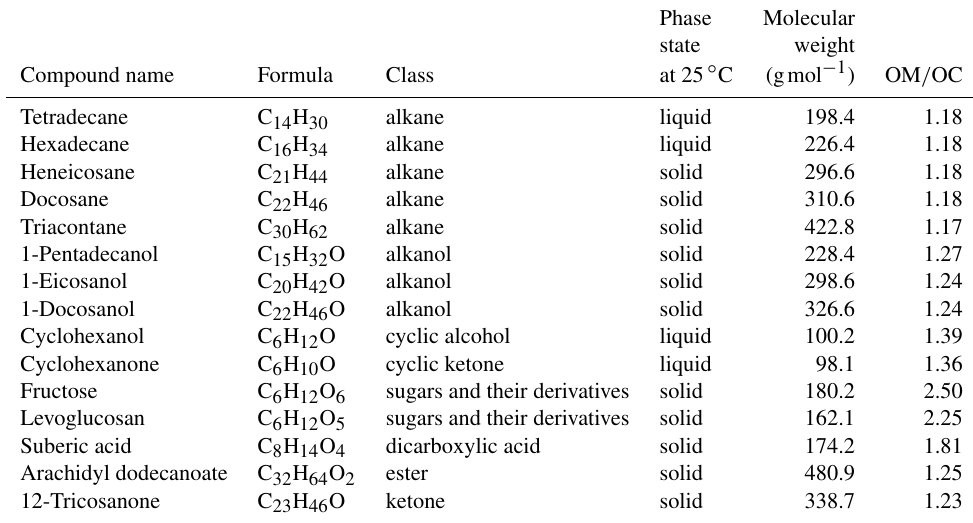
Table 1. Chemicals used in the calibration set to analyze the effect of different physical or chemical properties of organic molecules on aliphatic C − H absorbance